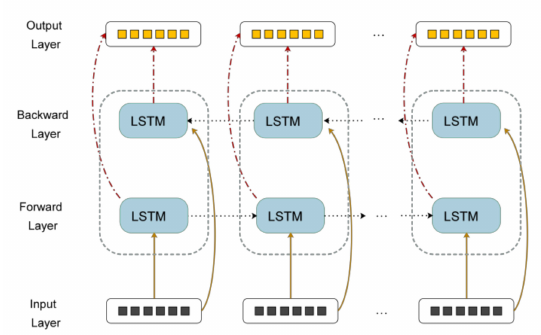
Figure 2. Bidirectional LSTM (BLSTM) structure